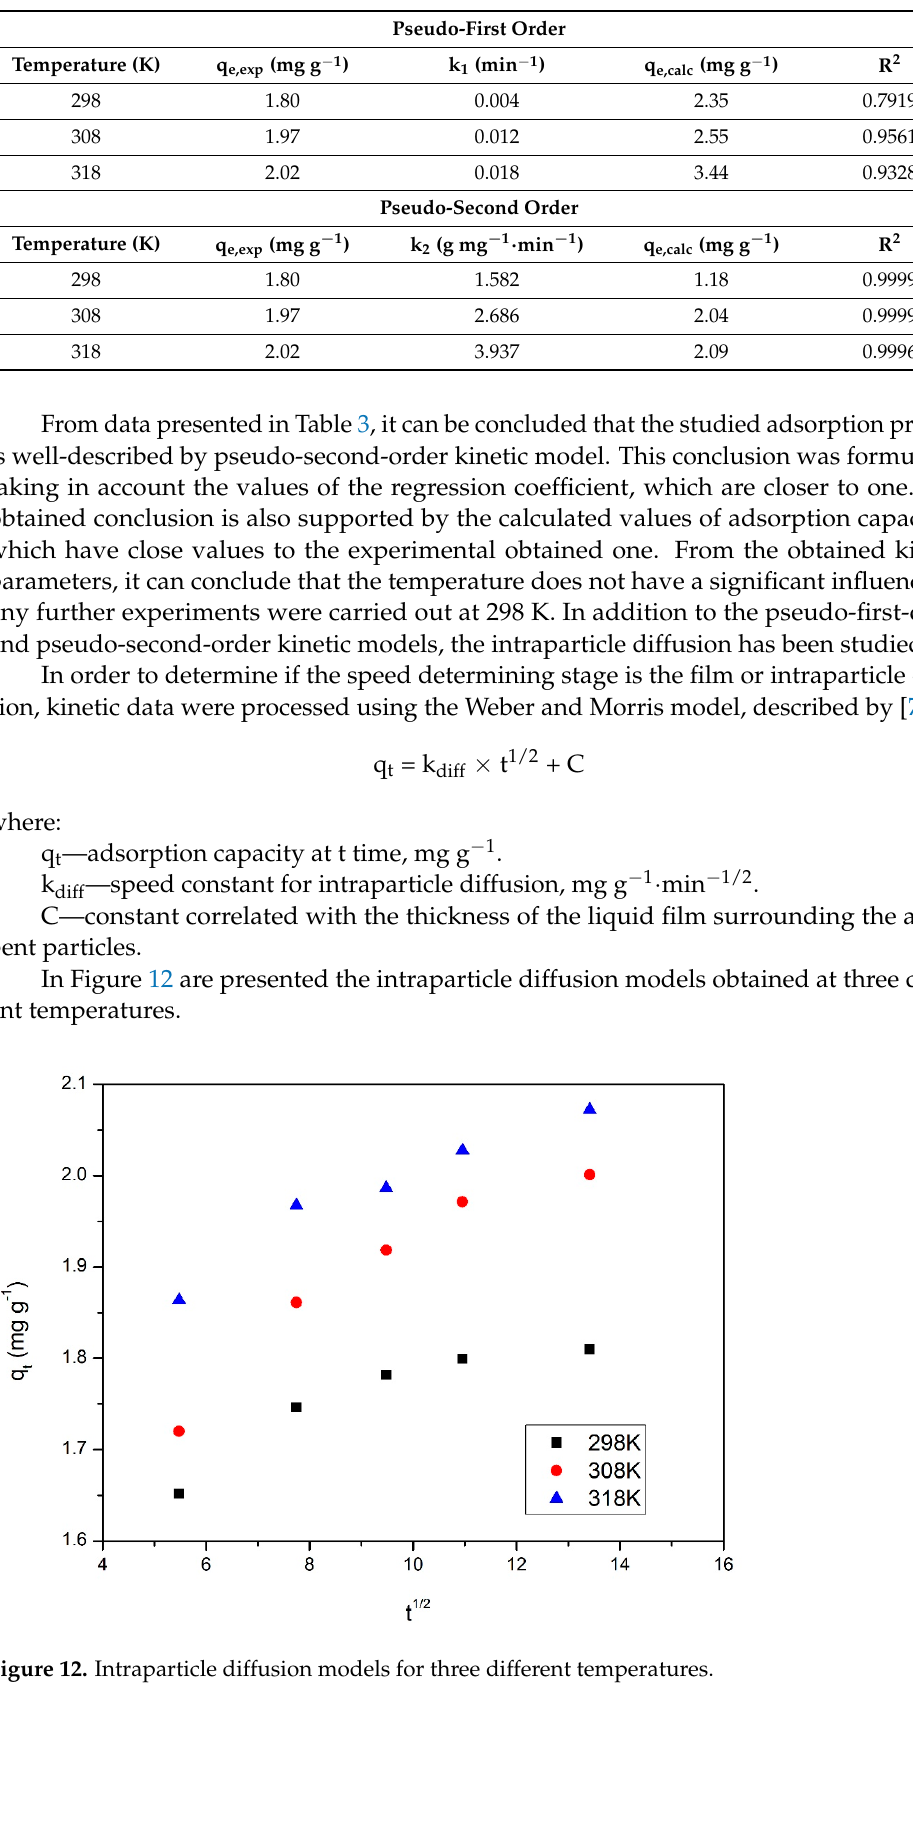
Table 3. Kinetic parameters obtained from data modelling.